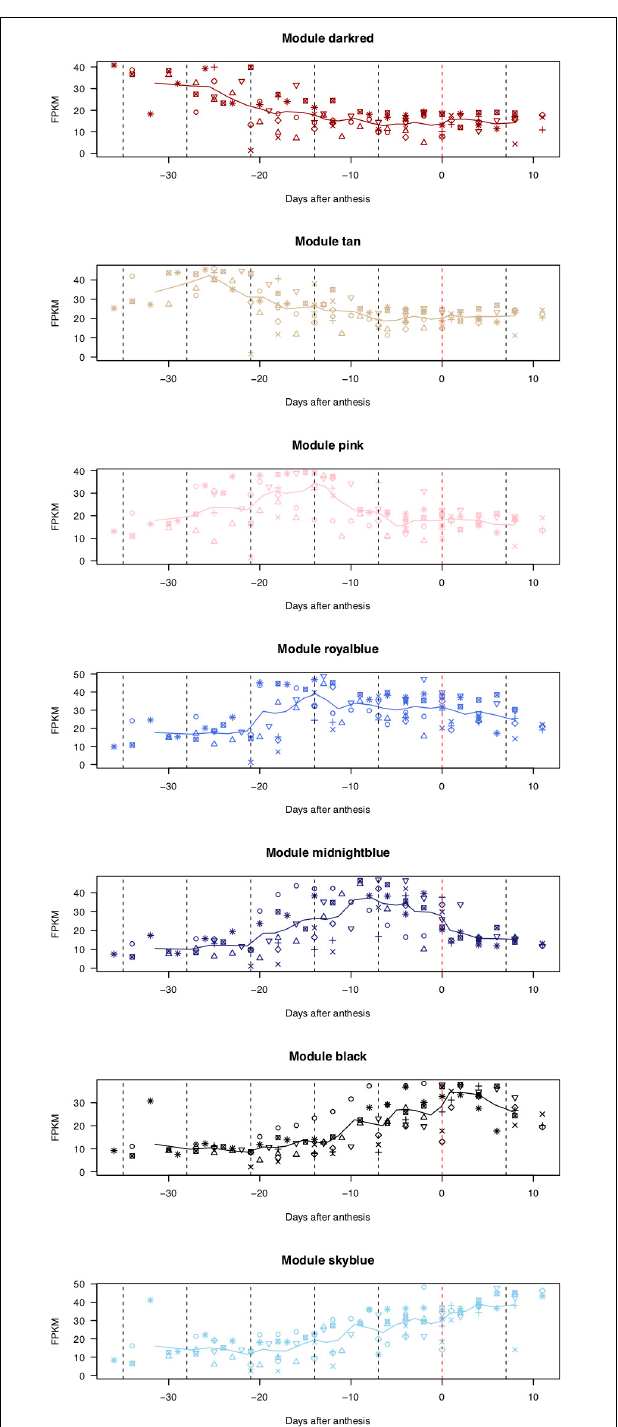
FIGURE 2 | Expression patterns of genes categorized into seven modules. X-axis indicates the number of days before (–) or after ( + ) the flowering day (0). Lines show moving averages of gene expression (sliding window size = 8, walking speed = 4). Symbols indicate biological replicates: KDRI in 2017 (circle); KDRI in 2019 (triangle); SU1 in 2019 (plus); SU2 in 2019 (cross); SU3 in 2019 (diamond); KPUA in 2019 (upside-down triangle); KPUB in 2019 (square cross); and KPUC in 2019